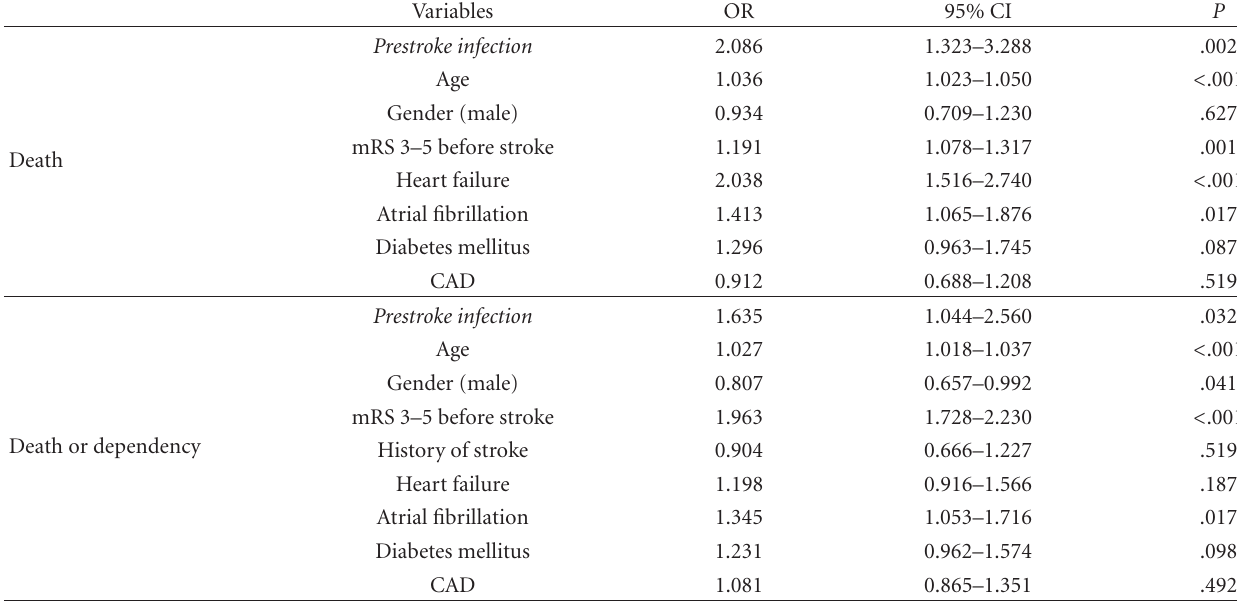
Table 3: Logistic regression for poor 30-days outcome (prestroke infection).